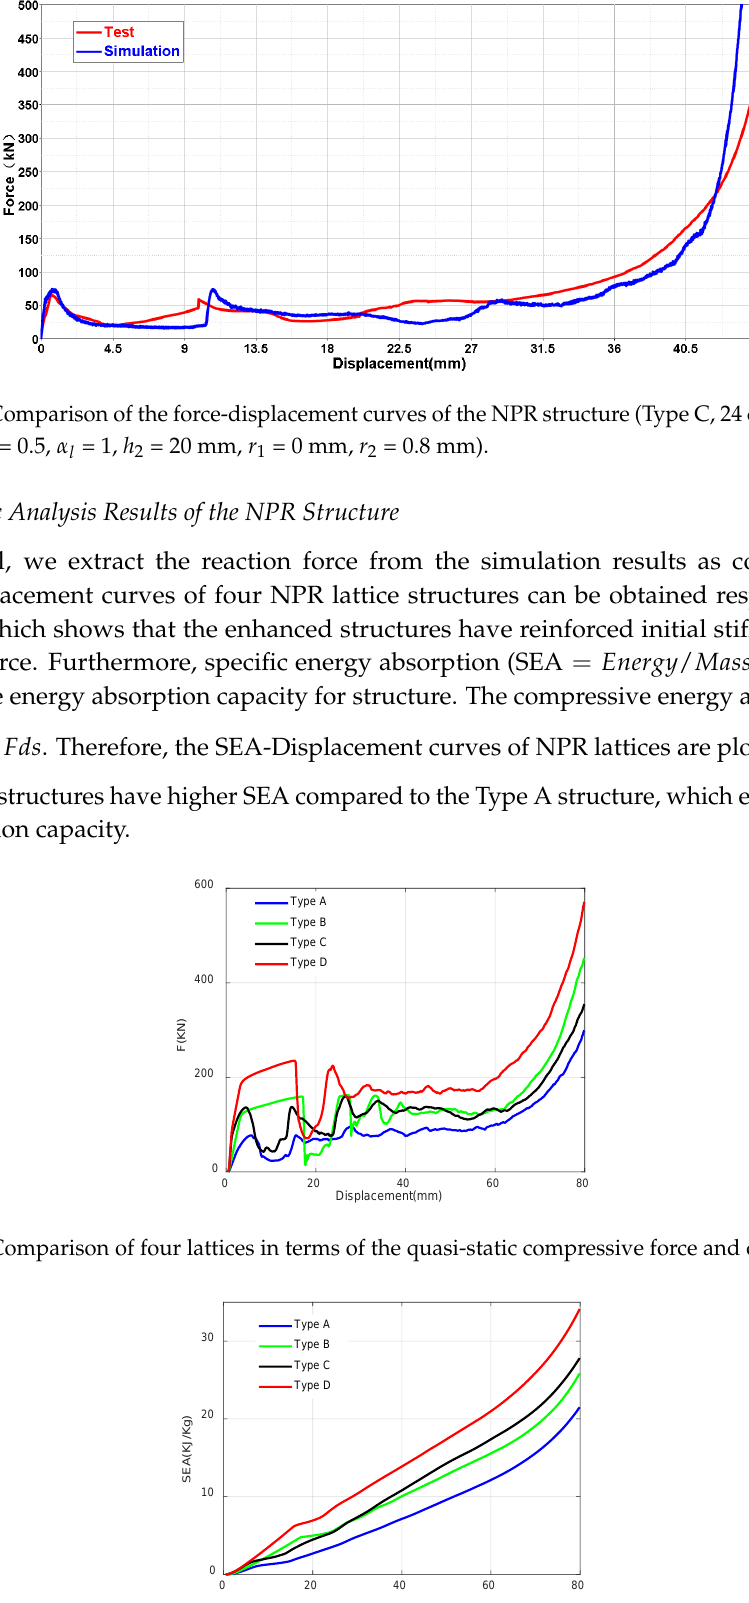
Figure 23. Comparison of four lattices in terms of quasi-static compressive SEA and displacement.